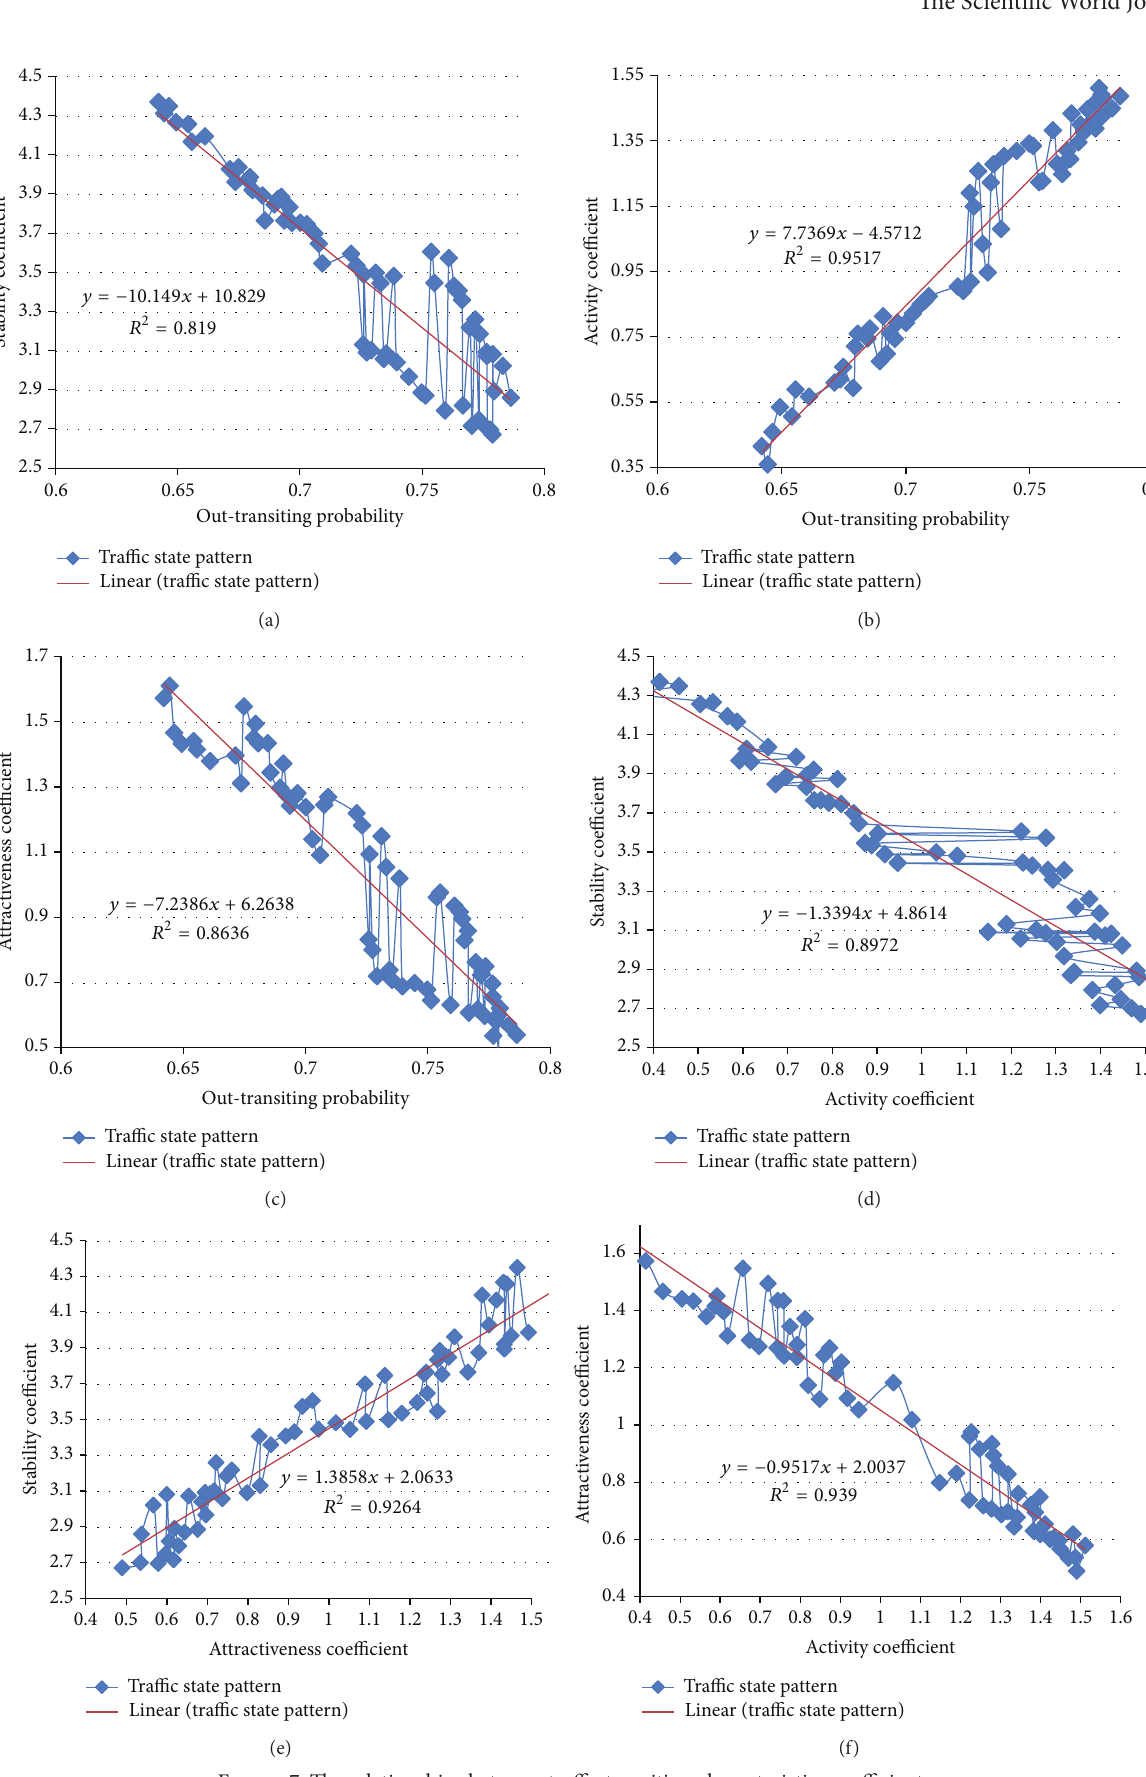
Figure 7: The relationships between traffic transition characteristics